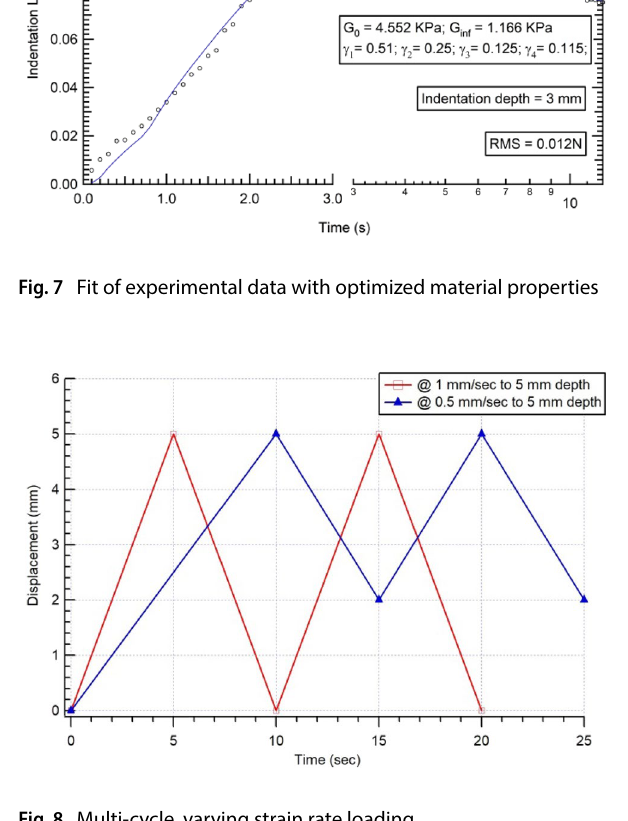
Fig. 8 Multi-cycle, varying strain rate